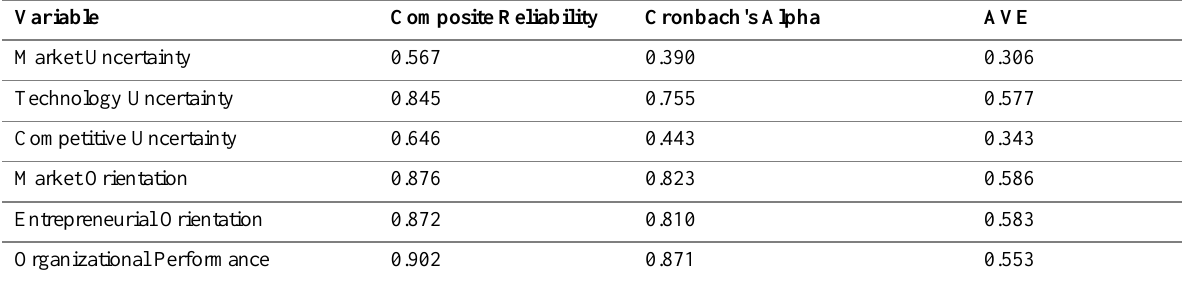
Table 1: Composite Reliability, Cronbach’s Alpha,